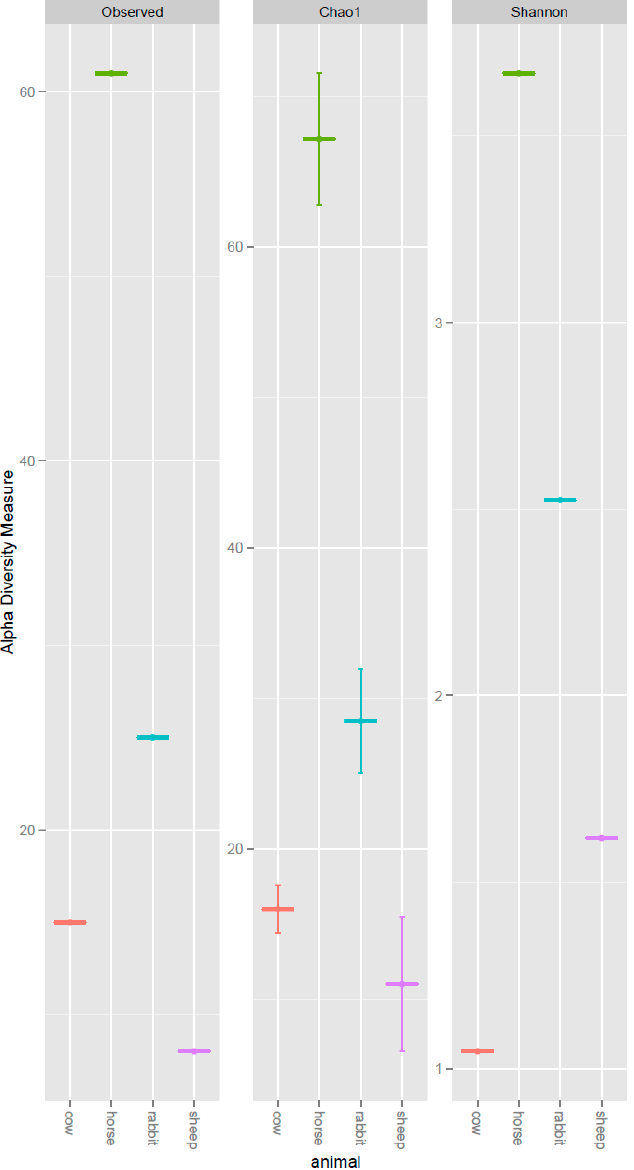
Figure 1. Alpha diversity measures of the deduced ACS amino acid sequences recovered from the rumens of cows and sheep, the ceca of rabbits, and the feces of horses. Observed = Observed OTU numbers; Chao1 = Chao estimator; Shannon = Shannon diversity index.